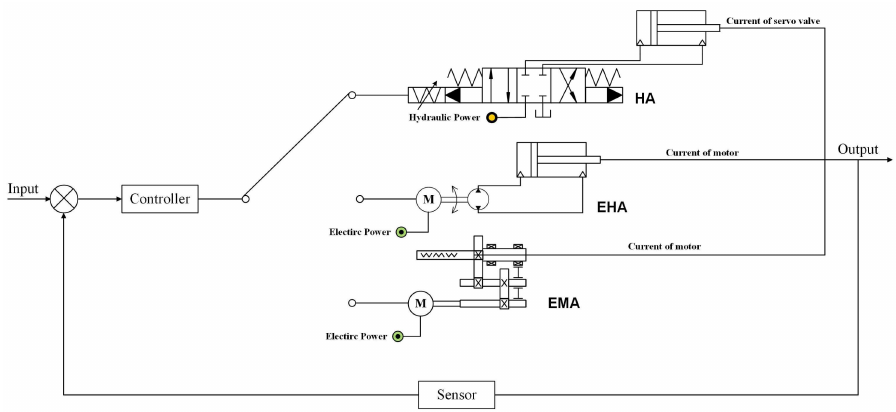
Figure 1. Structure of typical actuation